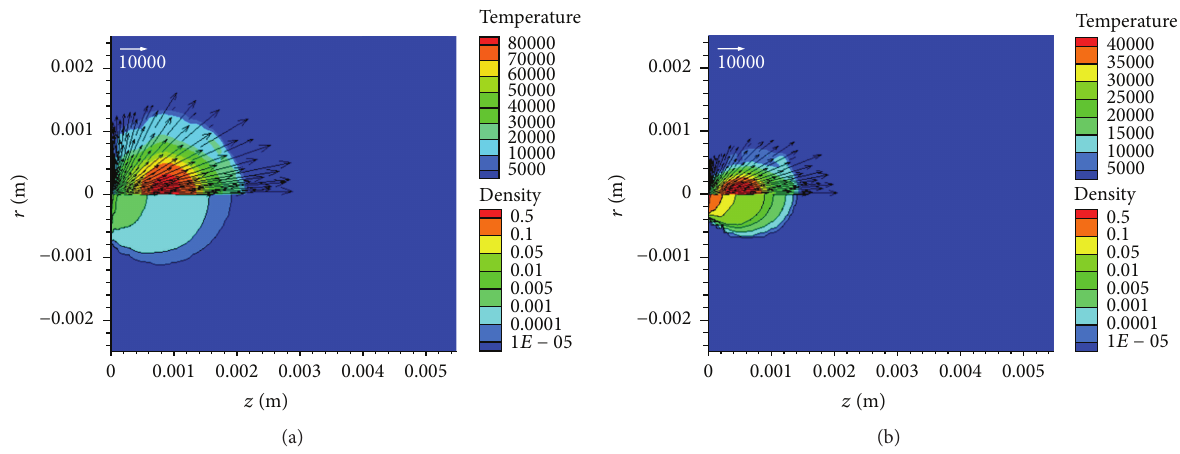
Figure 11: Distribution of density, temperature, and velocity in plasma induced during laser ablation of tungsten 100 ns after the beginning of the laser pulse for (a) 1064nm and (b) 355 nm laser wavelength.